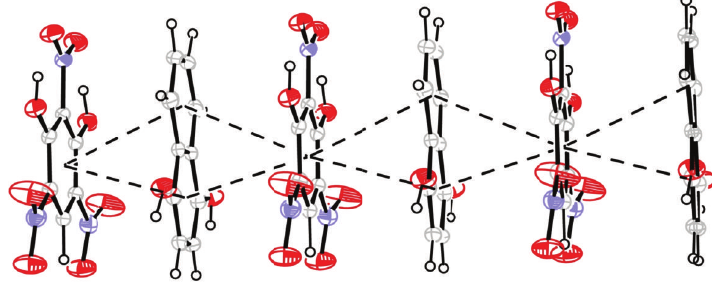
Figure 10: The 𝜋⋅⋅⋅𝜋 interactions in the molecules along the 𝑐 axis.